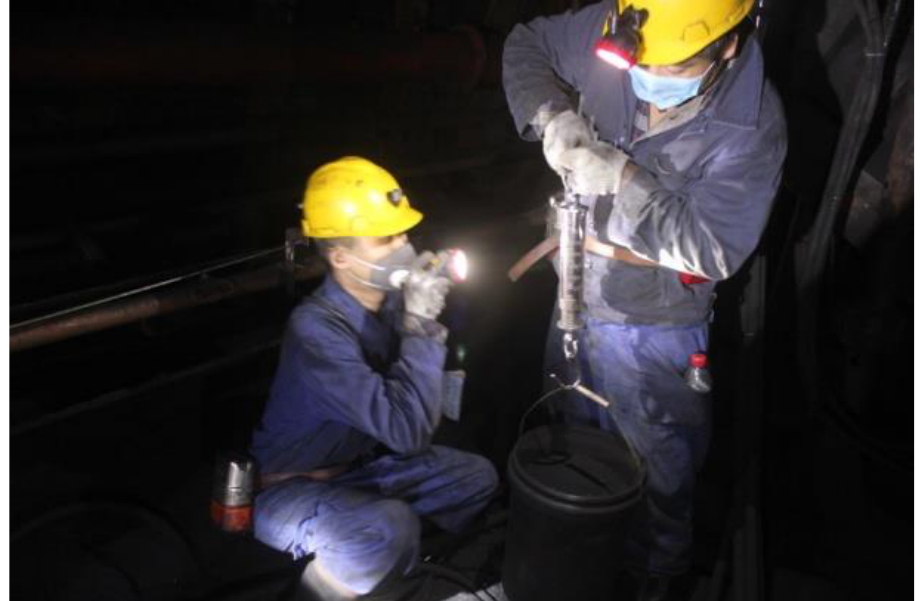
Figure 8. Field pictures.